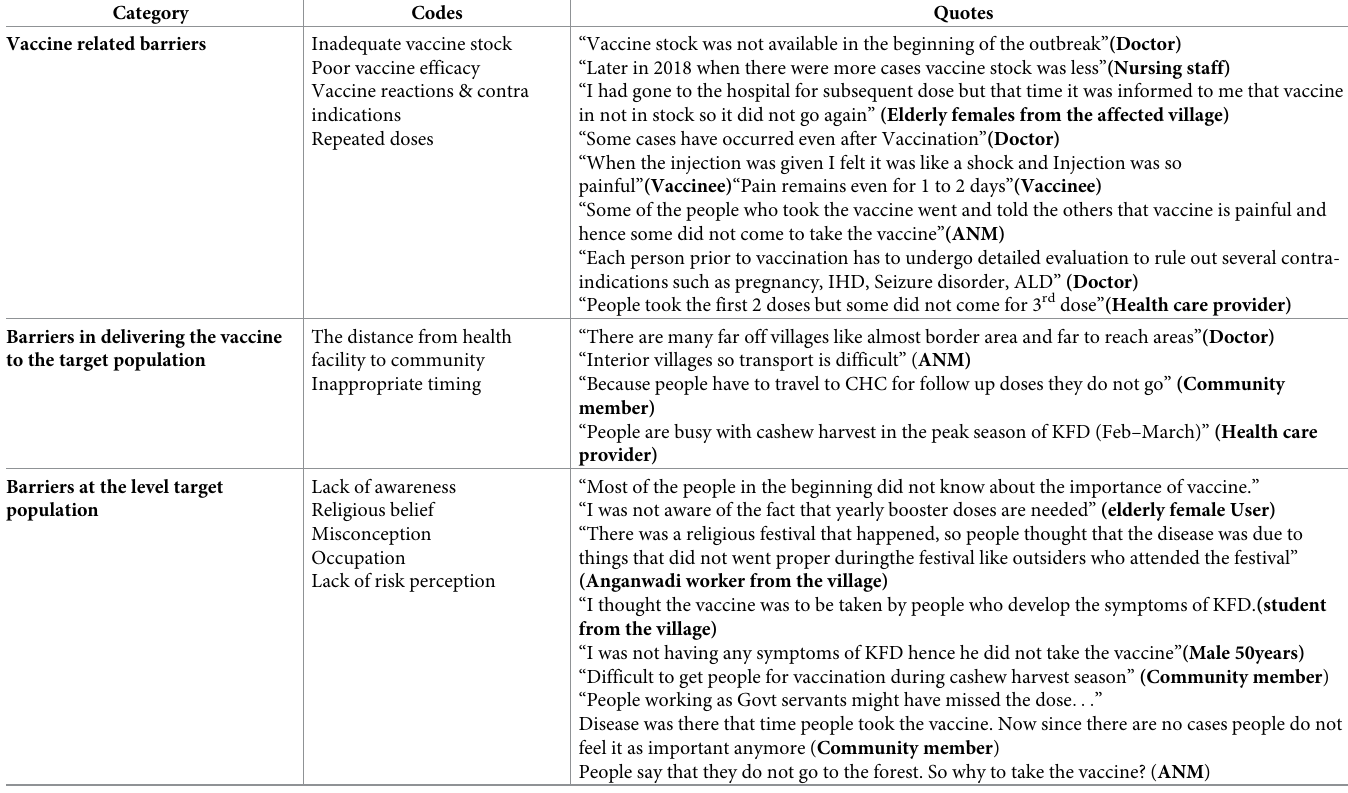
Table 3. Perceived barriers to vaccination coverage in the KFD affected villages, Goa, India.